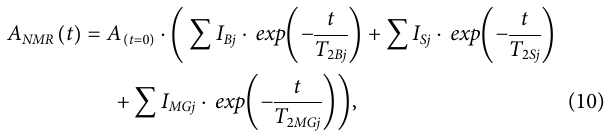
Frontiers in Earth Science |